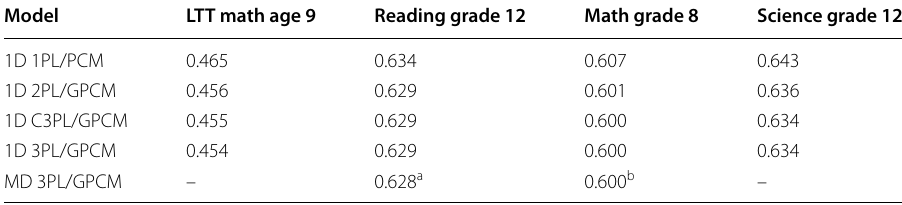
Table 4 Relative model fit statistics (PE-GH) for unidimensional (1D) and multidimensional (MD)